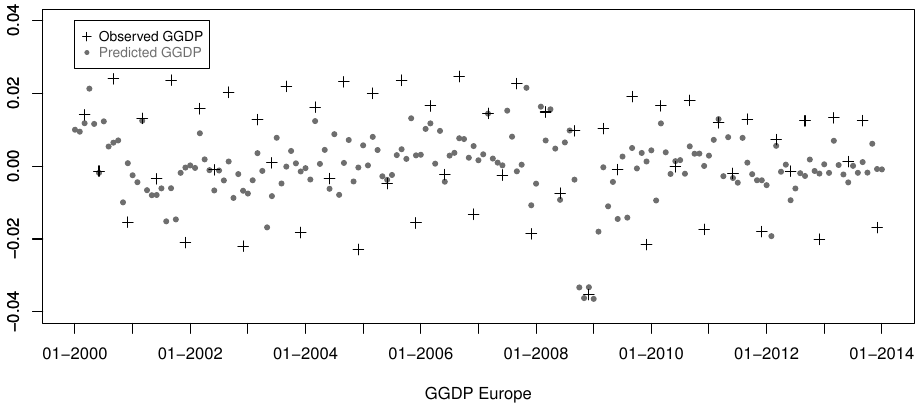
Figure 1. Observed quarterly (grey pluses)and estimated monthly (black dotes) European